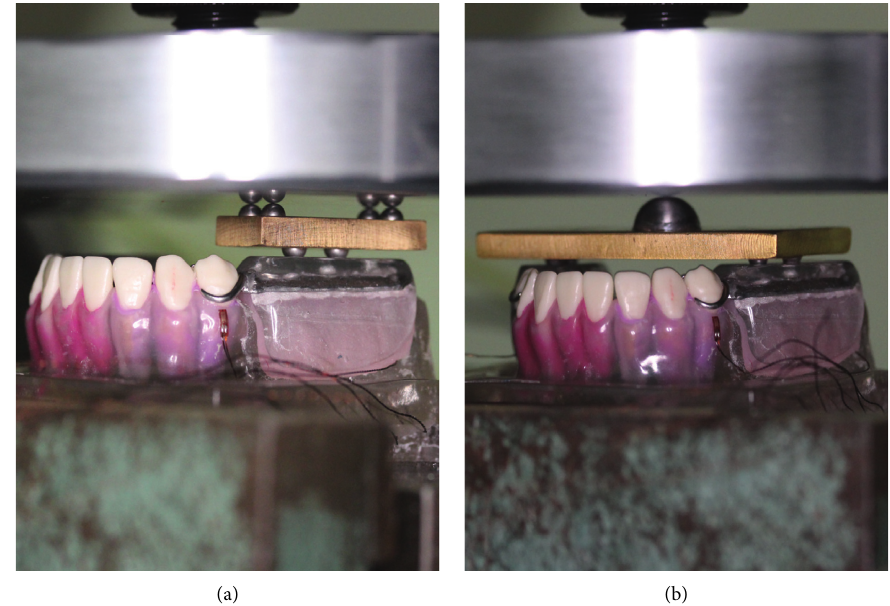
Figure 3: Axial loading. (a) Bilateral loading using a wide brass plate and stainless steel balls. (b) Unilateral loading using a narrow brass plate and stainless steel balls.